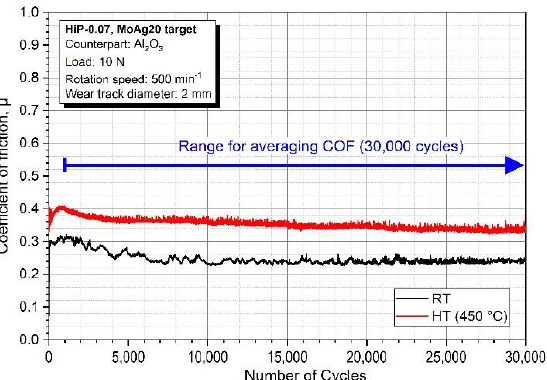
Figure 1. COF vs. number of cycles of MoN-Ag coated HSS samples. The samples used for this diagram are from the series HiP-0.07 (MoAg20 target). Pin-on-disk tests were performed at RT and at 450 °C.